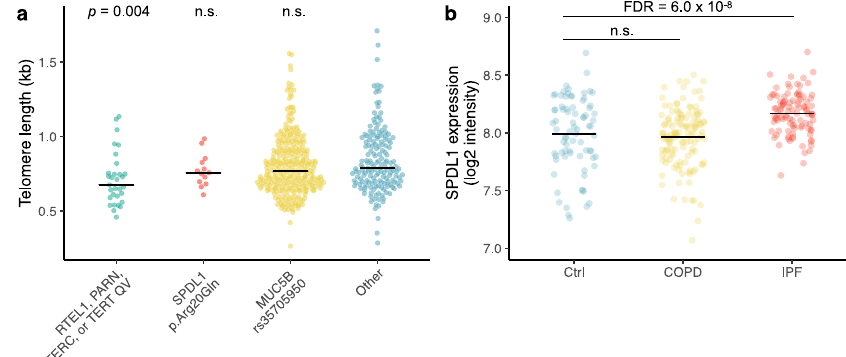
Fig. 4 Telomere lengths and expression data in individuals with IPF. a TelSeq-inferred 14 telomere lengths for the 507 IPF cases included in the PROFILE cohort strati fi ed by genetic risk factors. Logistic regression p -values are depicted for each group. QV = qualifying variant, n.s. = non-signi fi cant. b Expression of SPDL1 in lung tissue derived from 91 controls, 145 individuals with COPD, and 122 individuals with